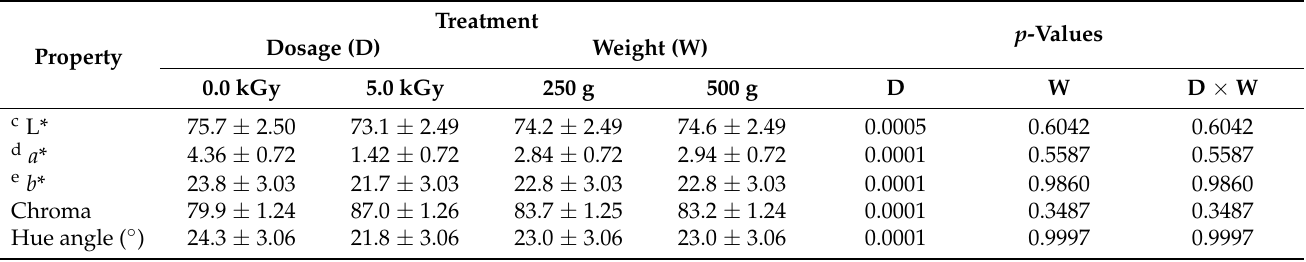
Table 2. Effects of the irradiation treatment (0.0 kGy and 5.0 kGy) and sample size (500 g and 250